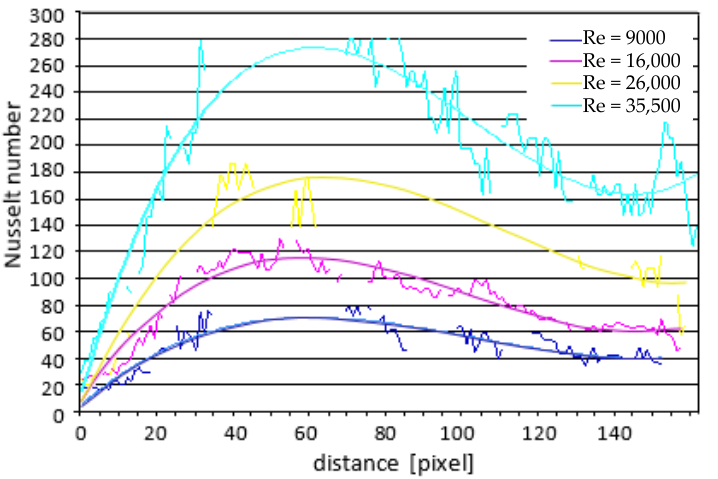
For comparison purposes, Figures 11 and 12 show the distribution of local Nusselt numbers for configuration_6 and _7 in the central and at the wall zone of the test section. In the case of ribbing of one wall of the test section, the differences in the Nusselt number are small. The ribbing of two walls increases the Nusselt numbers by about 19% at the tunnel wall zone compared to the measurements in the central zone, which is the result of diagonally arrange ribs which increased turbulence and partial flow of air towards the side walls of the measuring (test) section. Re = 9000 Re = 16,000 Re = 26,000 Re = 35,500